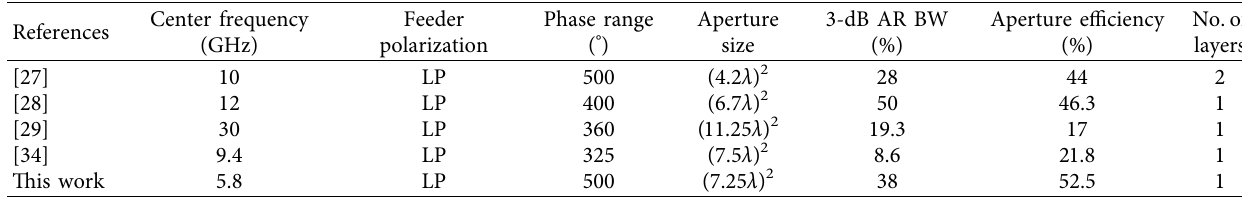
Figure 20: Power transmission measurement. Table 2: Comparison with other